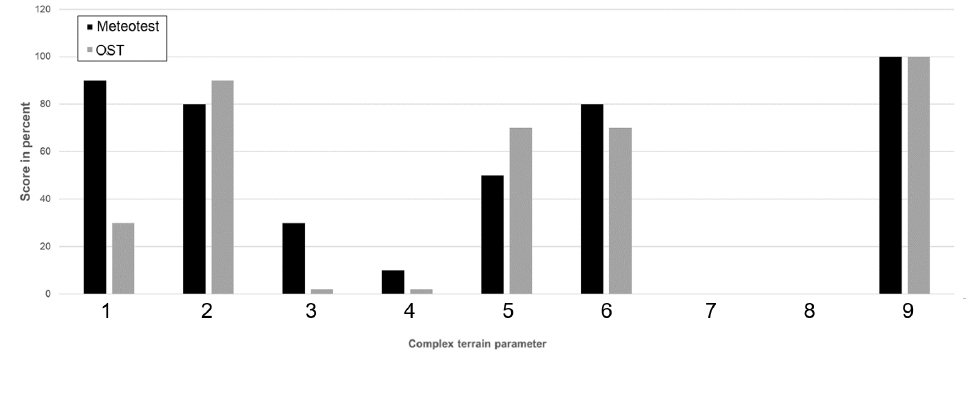
Figure A7. Answers to the ten complex terrain questions for Site